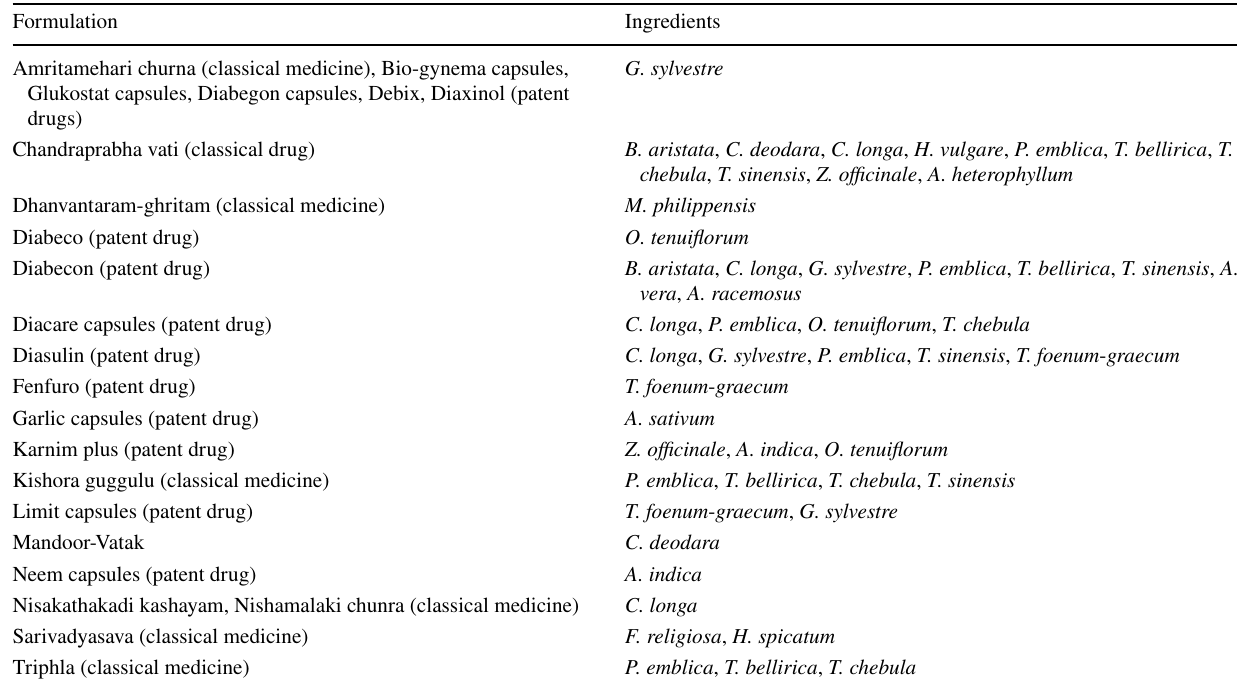
Table 2 Market formulations for diabetes treatment prepared from surveyed plants Formulation